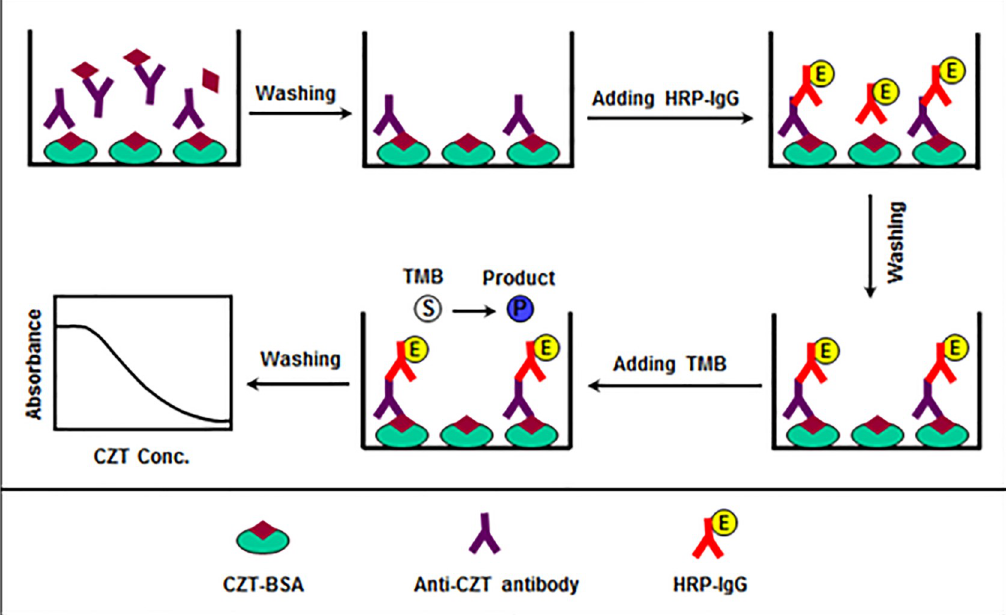
Fig 3. Schematic diagram for the proposed ELISA for